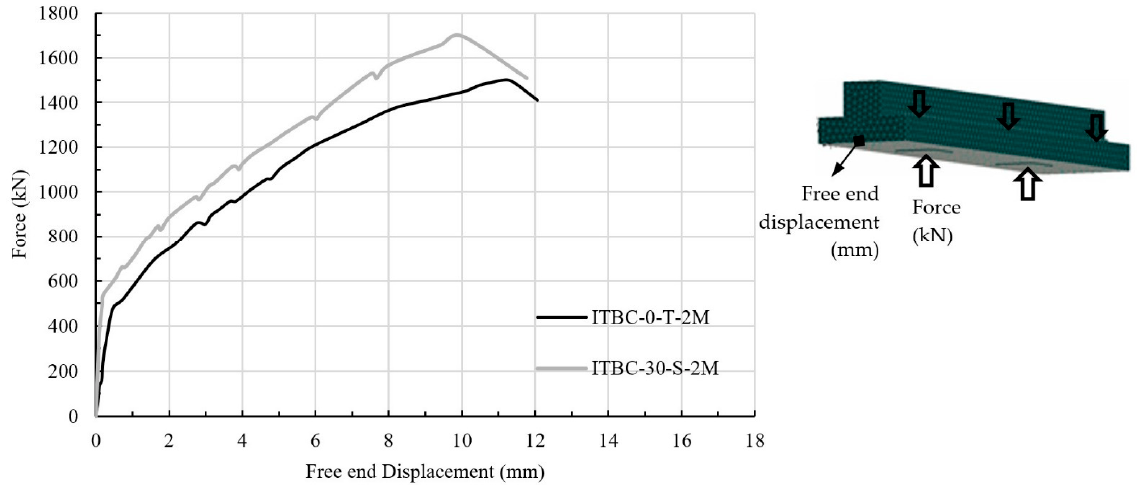
Figure 2. Experimental reaction force versus free end displacement relations.